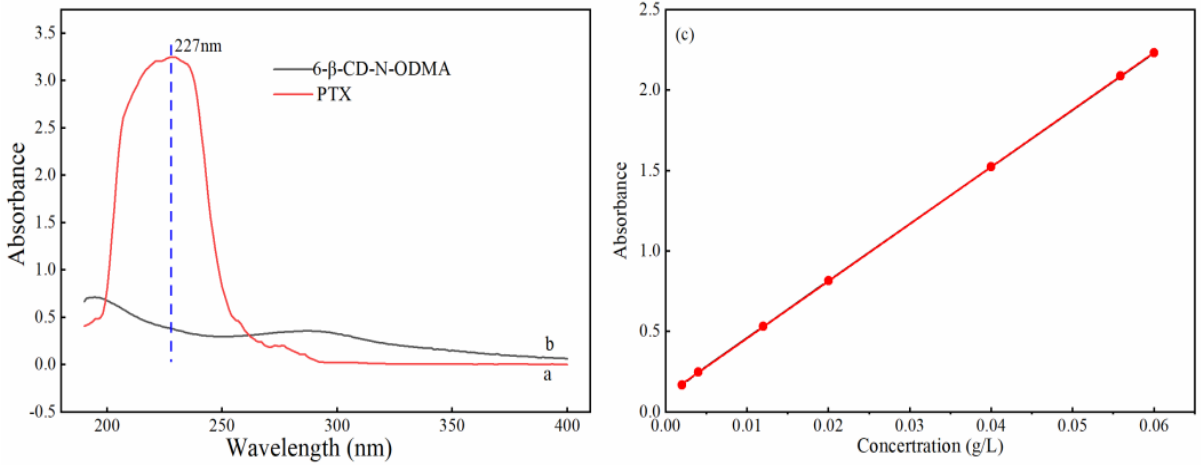
Figure 2. The UV-vis spectra of PTX (a), 6- β -CD-N-ODMA ( b ), and the standard curve of PTX ( c